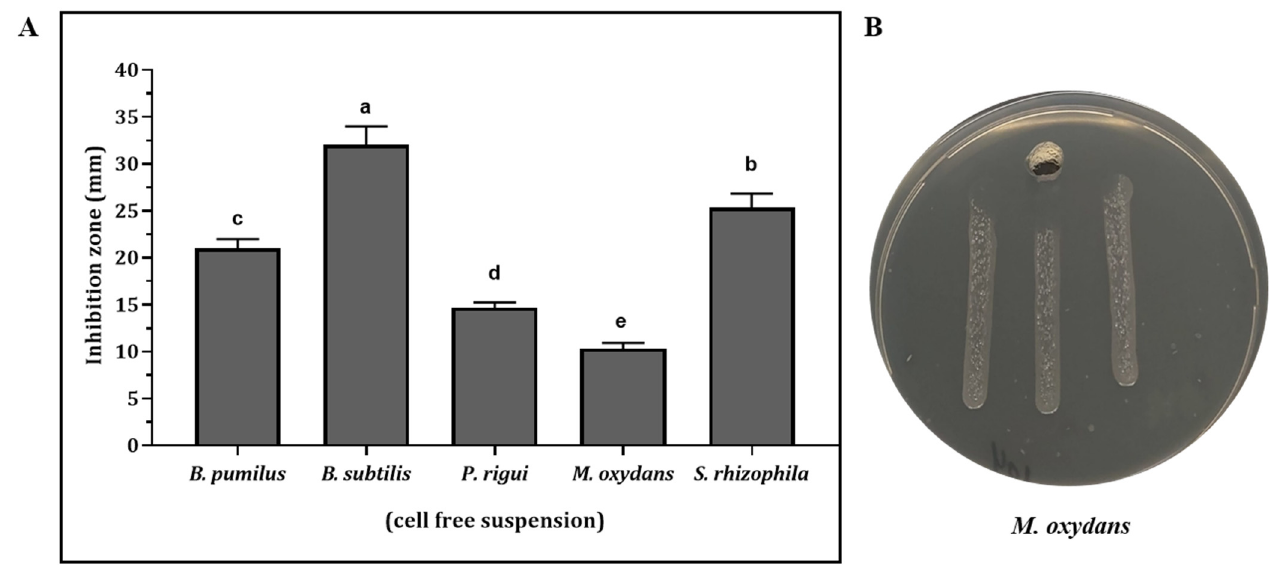
Figure 3. ( A ) Antimicrobial activity against X. fastidiosa ST53 of the culture filtrates of B. pumilus L36,